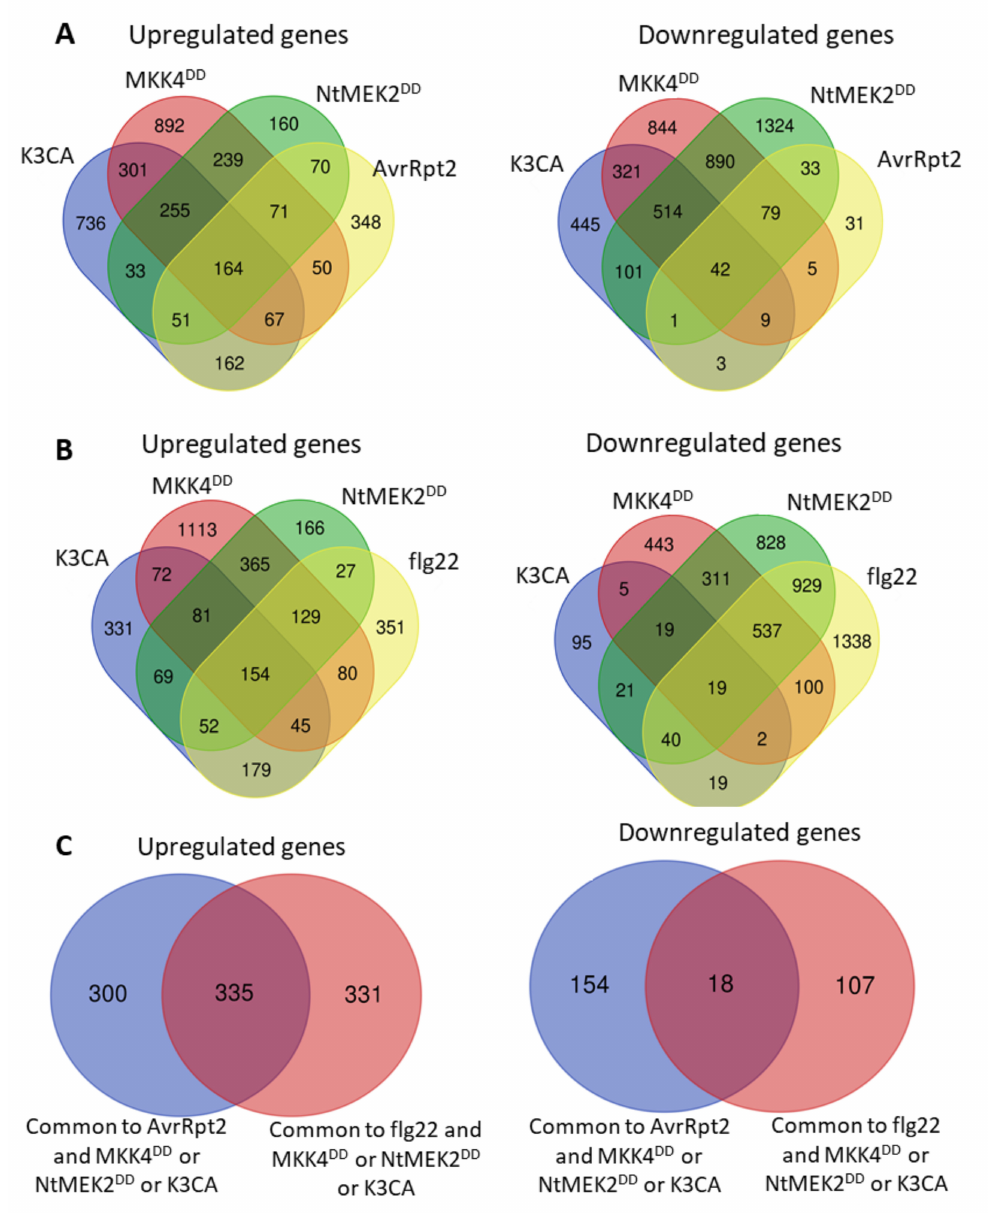
Figure 4. Overlap of the transcriptional reprogramming caused by sustained MPK3 / 6 activities, ETI and PTI. ( A ) Venn diagrams showing the overlap between genes regulated by sustained MPK3 / 6 activities (K3CA, MKK4 DD , NtMEK2 DD ) and expression of the e ff ector AvrRpt2. ( B ) Venn diagrams showing the overlap between genes regulated by sustained MPK3 / 6 activities (K3CA, MKK4 DD , NtMEK2 DD ) and the PAMP flg22. The list of flg22-responsive genes was extracted from Frei dit Frey et al. [21]. ( C ) Venn diagrams showing the overlap between genes regulated by sustained MPK3 / 6 activities (K3CA, MKK4 DD , NtMEK2 DD ), the expression of the e ff ector AvrRpt2 and the PAMP flg22. Venn diagrams were drawn with the webtool found at http: // bioinformatics.psb.ugent.be / webtools / Venn / . Based on the transcriptomic data, several functions of sustained MPK3 / 6 activity were